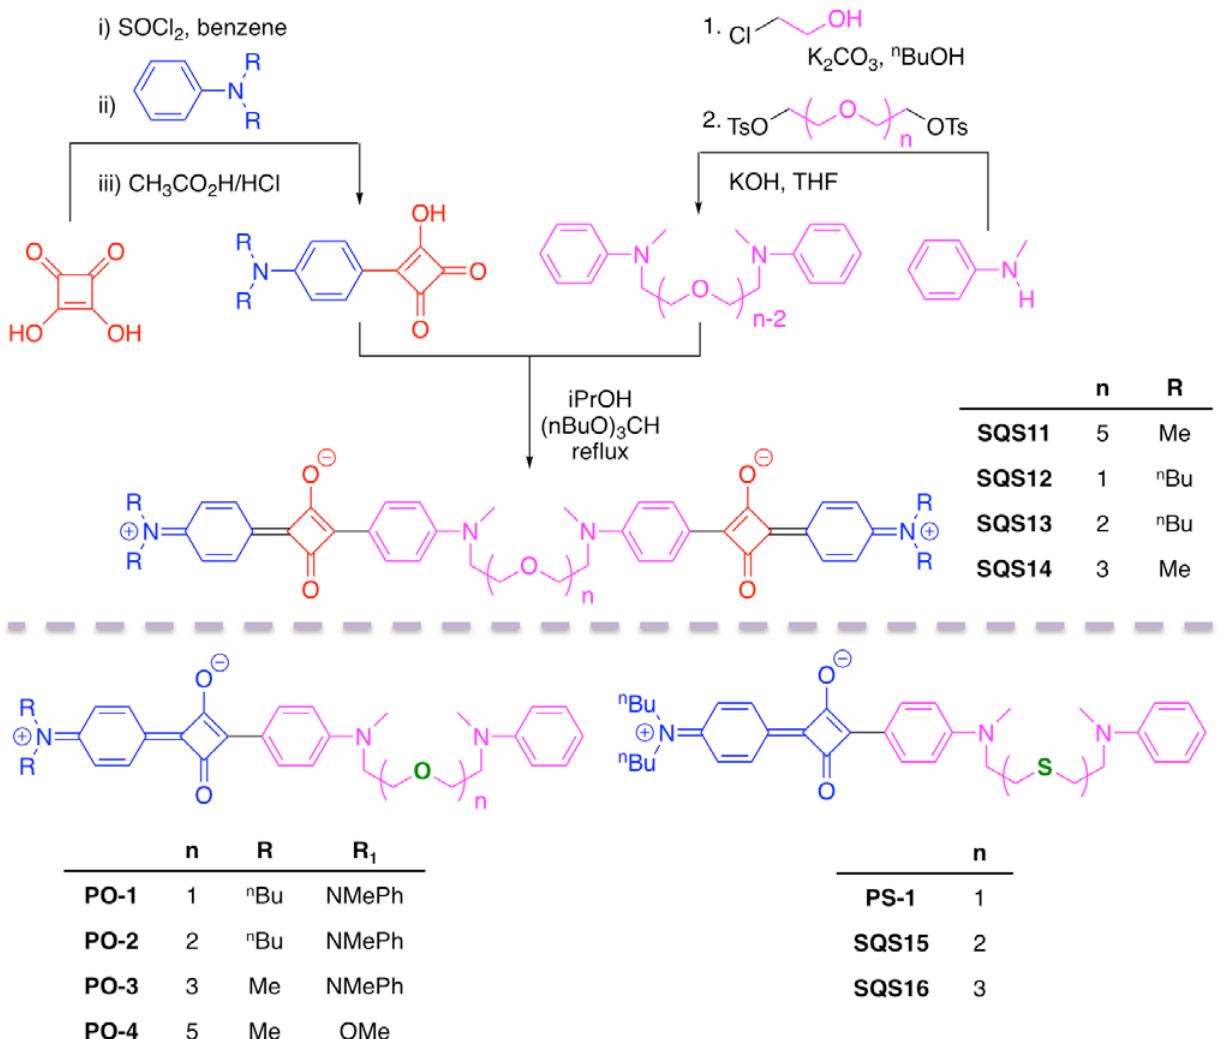
Scheme 8. Synthesis of podand-containing optical sensors SQS11 – SQS14 (top, [71,72]), and examples of optically silent Ca 2+ /Mg 2+ –hosts PO1–PO4 (bottom left, [72,73]) and thio-containing SQS15 and SQS16 , and thio-containing podand PS-1 (bottom right, [74]).